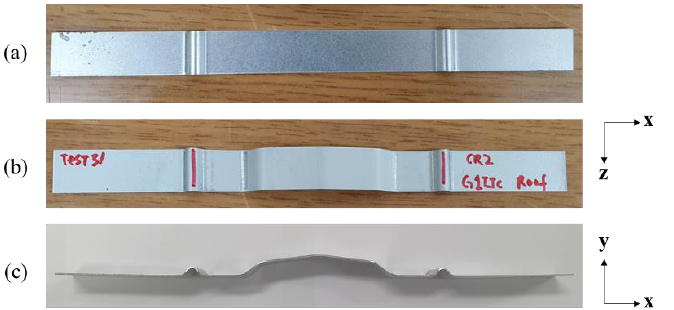
Figure 8. Fabricated specimen: ( a ) after the bead-forming process, ( b ) top view after the final formation process, and ( c ) side view.